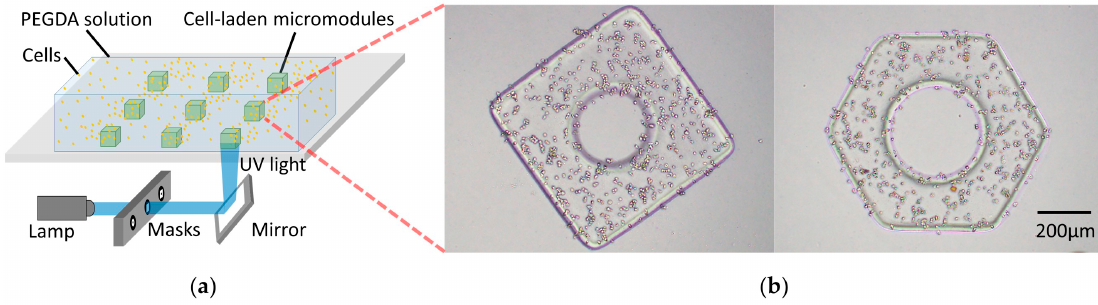
Figure 2. ( a ) Fabrication of cell-laden micromodules. ( b ) Optical images of two